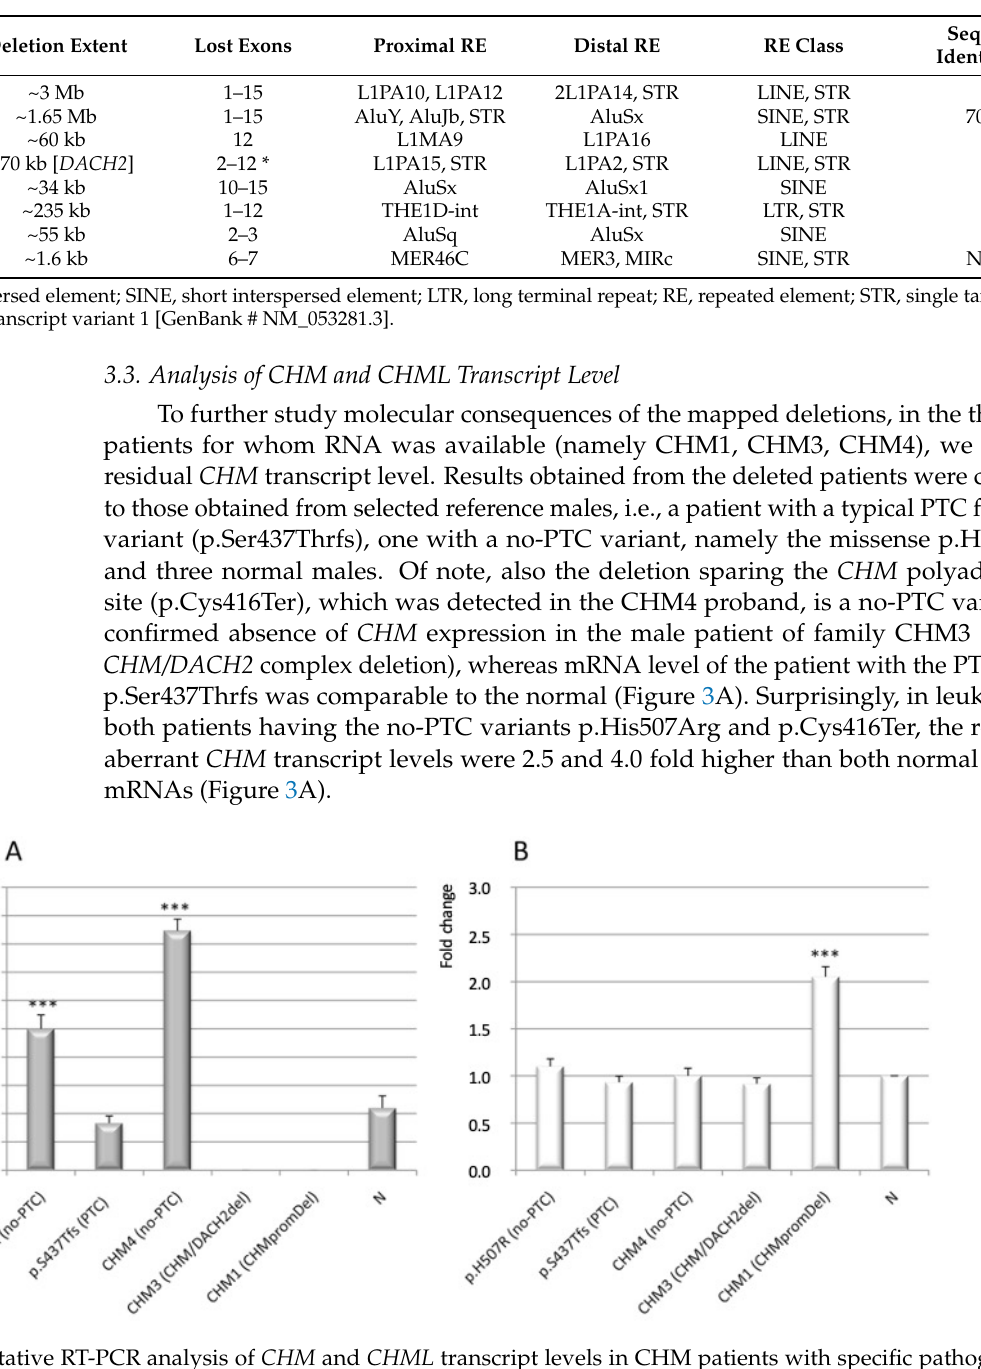
Figure 3. Quantitative RT-PCR analysis of CHM and CHML transcript levels in CHM patients with specific pathogenic variants (see text). ( A ) Transcript level of CHM is significantly higher in the patient with the missense variant p.His570Arg and in the CHM4 patient, both expressing no-PTC mRNAs, than in normal controls (N); patient with a classic PTC-associated pathogenic variant (p.Ser437Trpfs) has CHM mRNA level similar to normal controls; CHM expression was null in patients CHM3 ( CHM / DACH2 del) and CHM1 (a 3 Mb deletion that removed the whole CHM gene including its promoter). ( B )